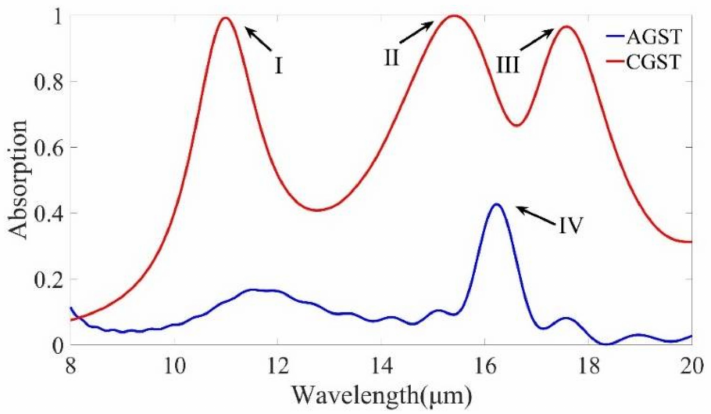
Figure 2. Total absorption at normal incidence for a structure with amorphous (AGST) and crystalline (CGST) stable structural